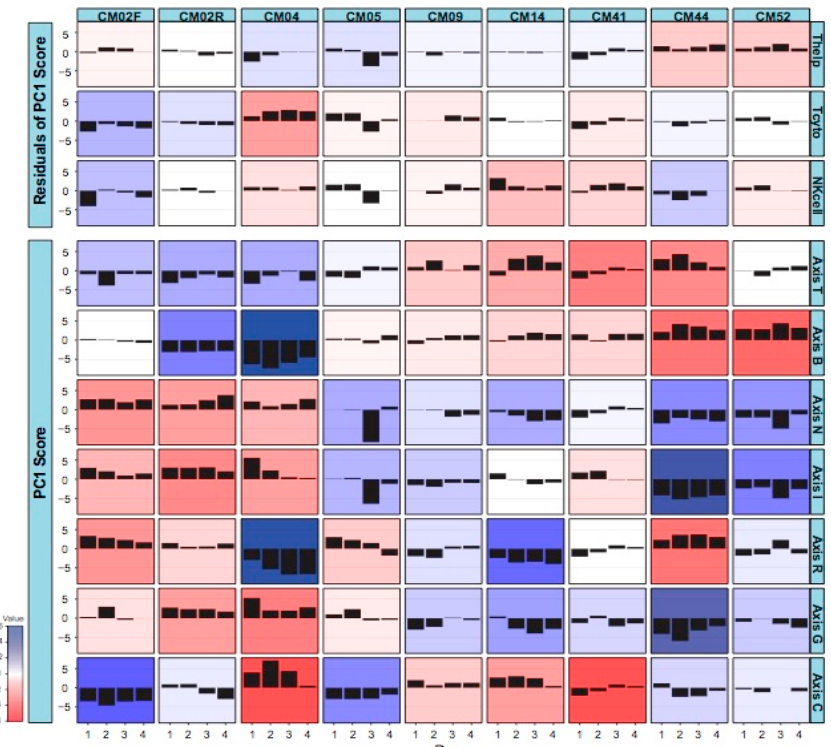
Figure 3. Standardized change in BIT by individual and time. Each box shows the difference between the sample PC1 score and the sample mean for the indicated individual from Day 1 to Day 4 of sampling. Red implies strong elevation, and blue strong reduction in the expression of genes in the Axis.